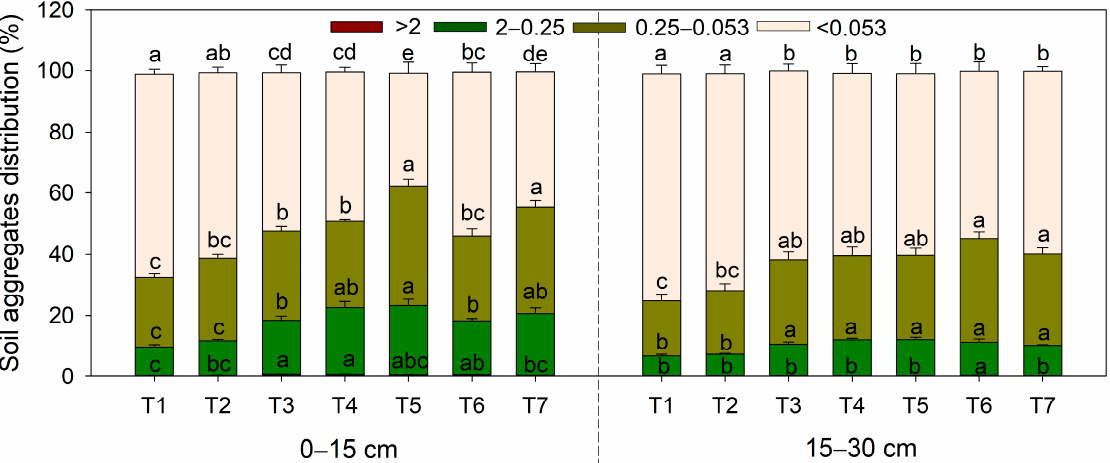
Figure 3. Soil aggregate distributions at 0–15 and 15–30 cm depths as affected by different treatments in 2020 after 12 years of annual fertilization. T1: N application by farmers (240 kg N ha − 1 ); T2: optimized N management (Nopt); T3: biochar + Nopt; T4: straw + Nopt; T5: manure + Nopt; T6: compost + Nopt; T7: biogas residue + Nopt. Lower-case letters indicate significant differences among treatments of each aggregate size at a specific soil depth at p < 0.05 level.